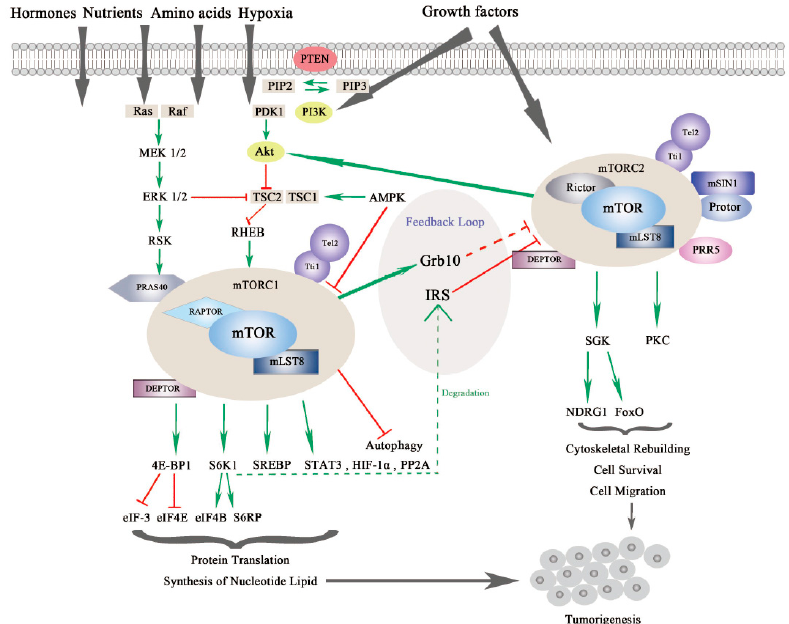
Figure 1. The mammalian or mechanistic target of rapamycin (mTOR) complexes and signaling pathway of mTORC1 and mTORC2. mTORC1 is responsive to nutrients, hormones, amino acids, hypoxia and growth factors, while mTORC2 responds to growth factors. mTORC1 and mTORC2 share common subunits of mTOR kinase, mLST8, DEPTOR (DEP domain-containing mTOR-interacting protein), Tel 2 and Tti 1. mTORC1 additionally binds with RAPTOR (Regulatory-associated protein of mTOR) and PRAS40 (Proline-rich substrate of 40 kDa), and mTORC2 combines with RICTOR and mSIN1 (Mammalian stress-activated protein kinase interacting protein 1) as well as Protor and PRR5 (Proline-rich protein 5). mTORC1 is regulated by PI3K/Akt (Phosphoinositide 3-kinase/serine-threonine protein kinase) and Ras-MAPK (Mitogen activated protein kinase) signaling pathways. mTORC1 regulates protein translation and synthesis of nucleotide lipid via 4E-BP1 and S6K1 and downstream effectors. mTORC1 also activates STAT3 (Signal transducer and activator of transcription), HIF-1 α (Hypoxia-inducible factor 1 α ) and PP2A (Protein phosphatase 2A) in tumorigenesis. mTORC2 regulates SGK (Serum glucose kinase) and PKC (Protein kinase C) to promote cell survival, cytoskeleton reorganization and cell migration. mTORC2 is negatively modulated by mTORC1 via different feedback loops mediated by IRS (insulin receptor substrate) or Grb10. mTORC1 and mTORC2 can both contribute to turmorigenesis through different mechanisms